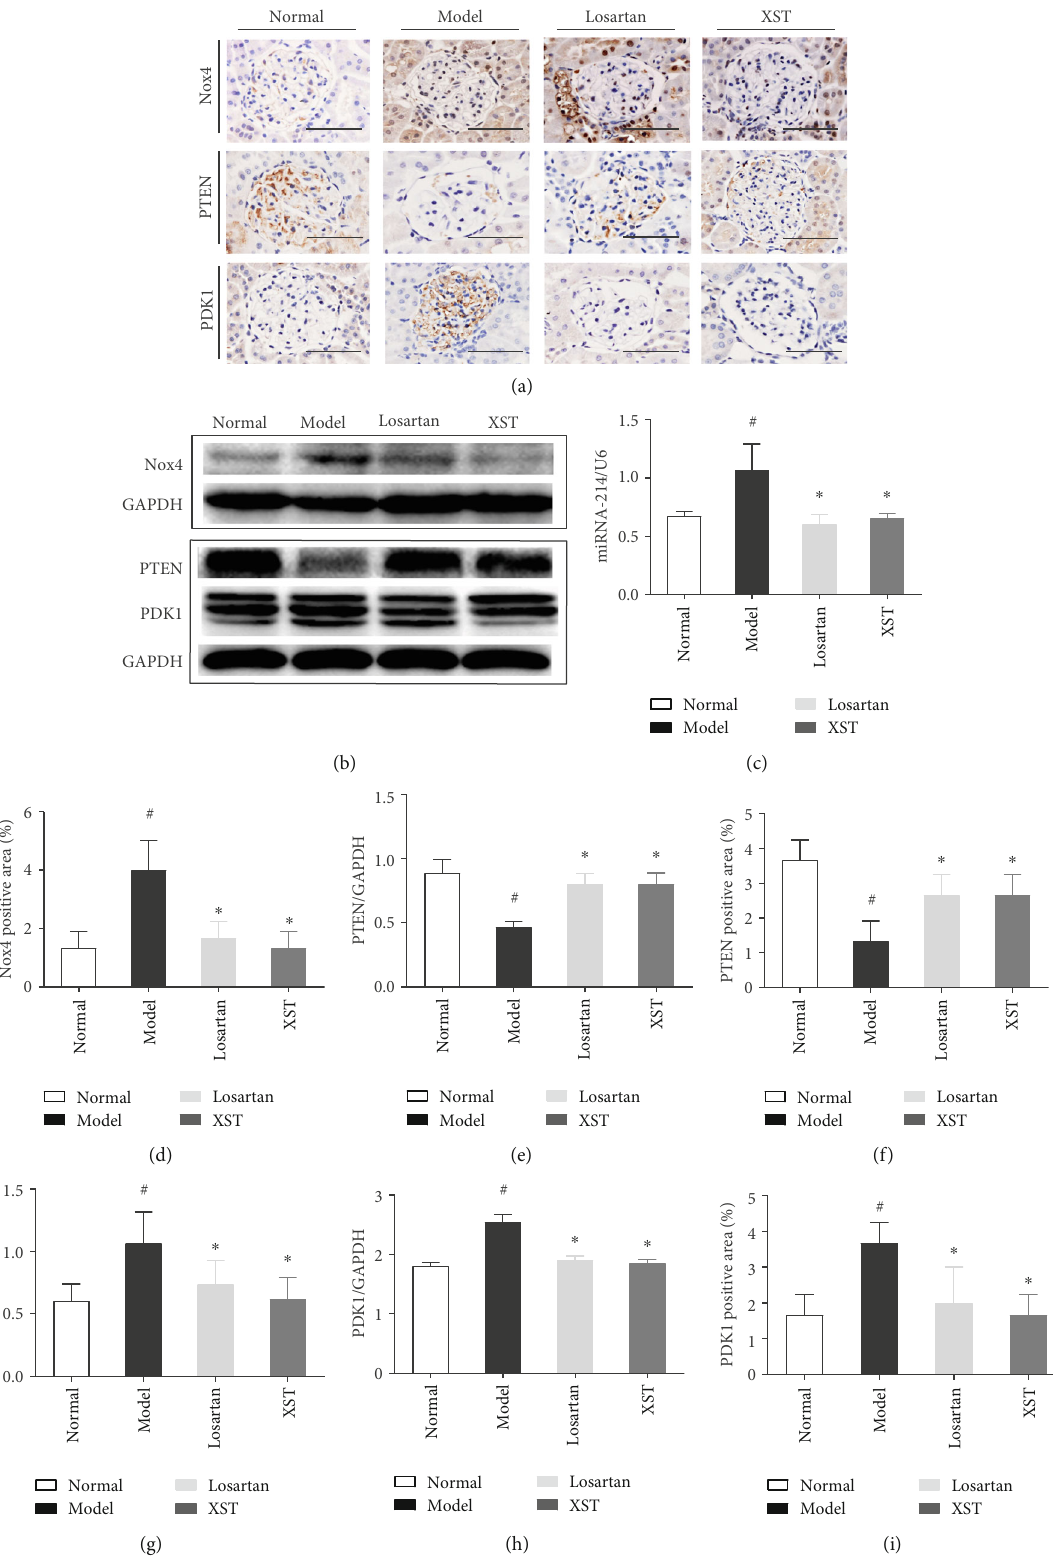
Figure 4: E ff ects of XST on Nox4, miRNA-214, PTEN, and PDK1 expression in diabetic rats. Representative immunohistochemical staining (a) and western blotting (b) for Nox4, PTEN, and PDK1 in glomerulus. Representative real-time quantitative PCR for miRNA-214 (c). Quantitative analysis for Nox4, PTEN, and PDK1 (d – i). Scale bar = 100 μ m. # P < 0 : 05 vs. normal; ∗ P < 0 : 05 vs.